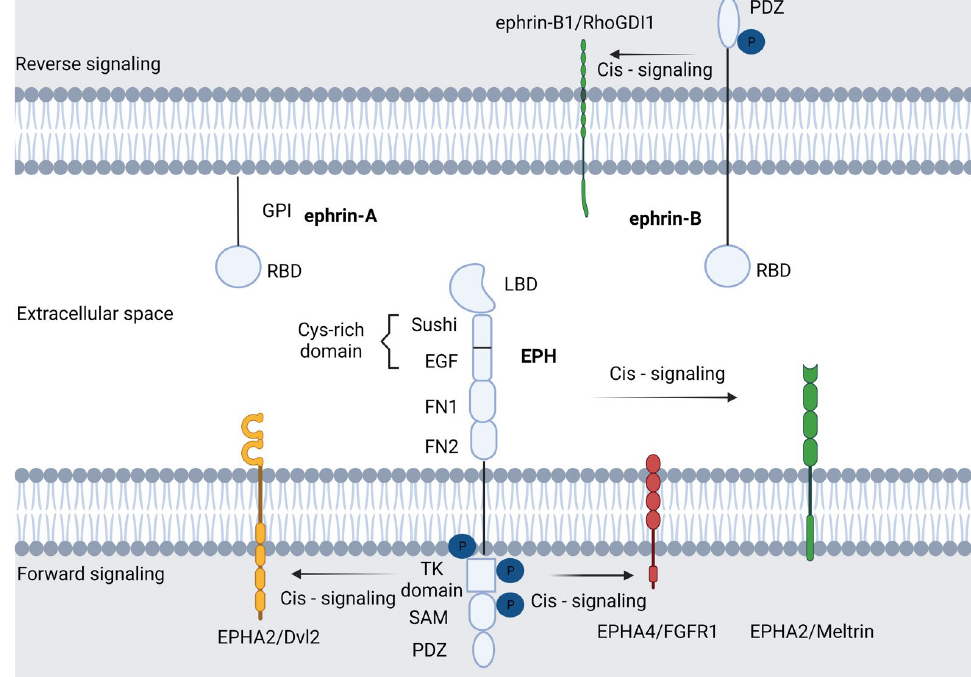
Figure 1. Basic molecular structure of the EPH/ephrin signaling compartment. In the plasma membrane, ephrin-A ligands are hooked by a glycosylphosphatidylinositol (GPI) anchor, although they can also activate distant EPH receptors. On the other hand, ephrin-B ligands contain a transmem- brane domain and a cytoplasmic segment. EPHs/ephrin interaction results in the beginning of a molecular series of events. Forward signaling is triggered by EPH–ephrin binding as well as through EPH interplay with various biomolecules and signaling pathways. Reverse signaling is stimulated by the EPHs in the ephrin-expressing cells. Cis-signaling is the interaction of EPHs and ephrins with molecules on the same cell membrane. Proteins that encompass Src Homology 2 (SH2) or PDZ domains participate in the transmission of the downstream signal through their interaction with ephrins. Created with